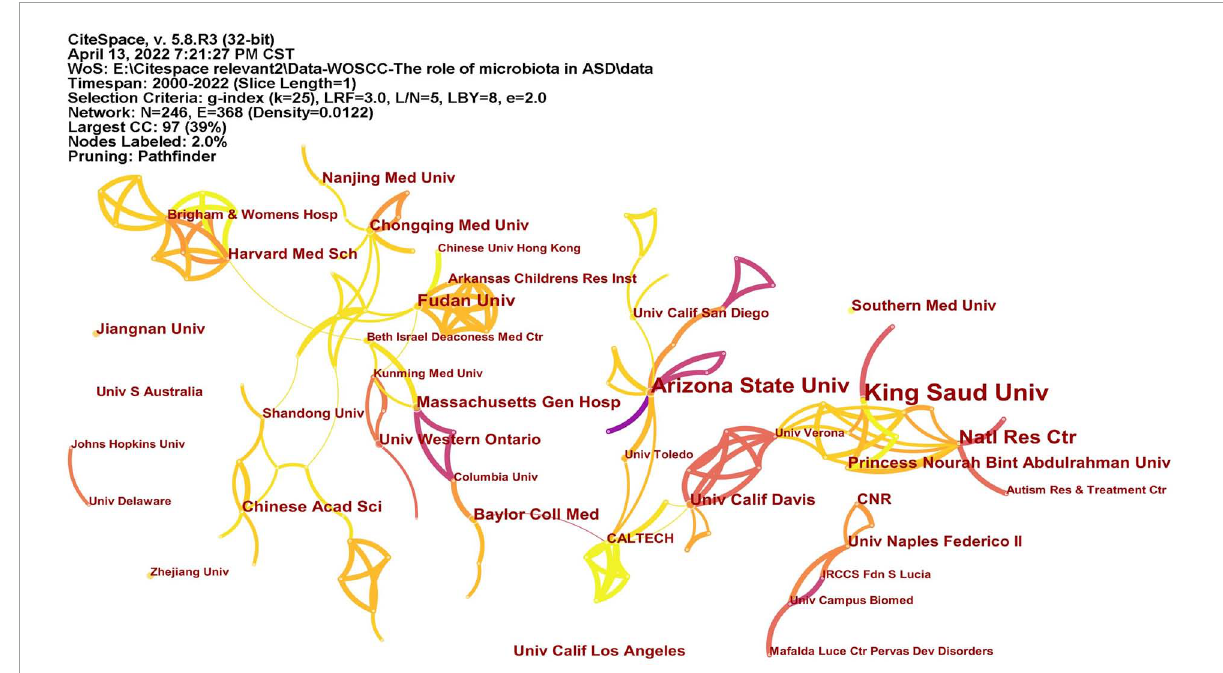
FIGURE4 The network of institutes with articles published. The lines represent the